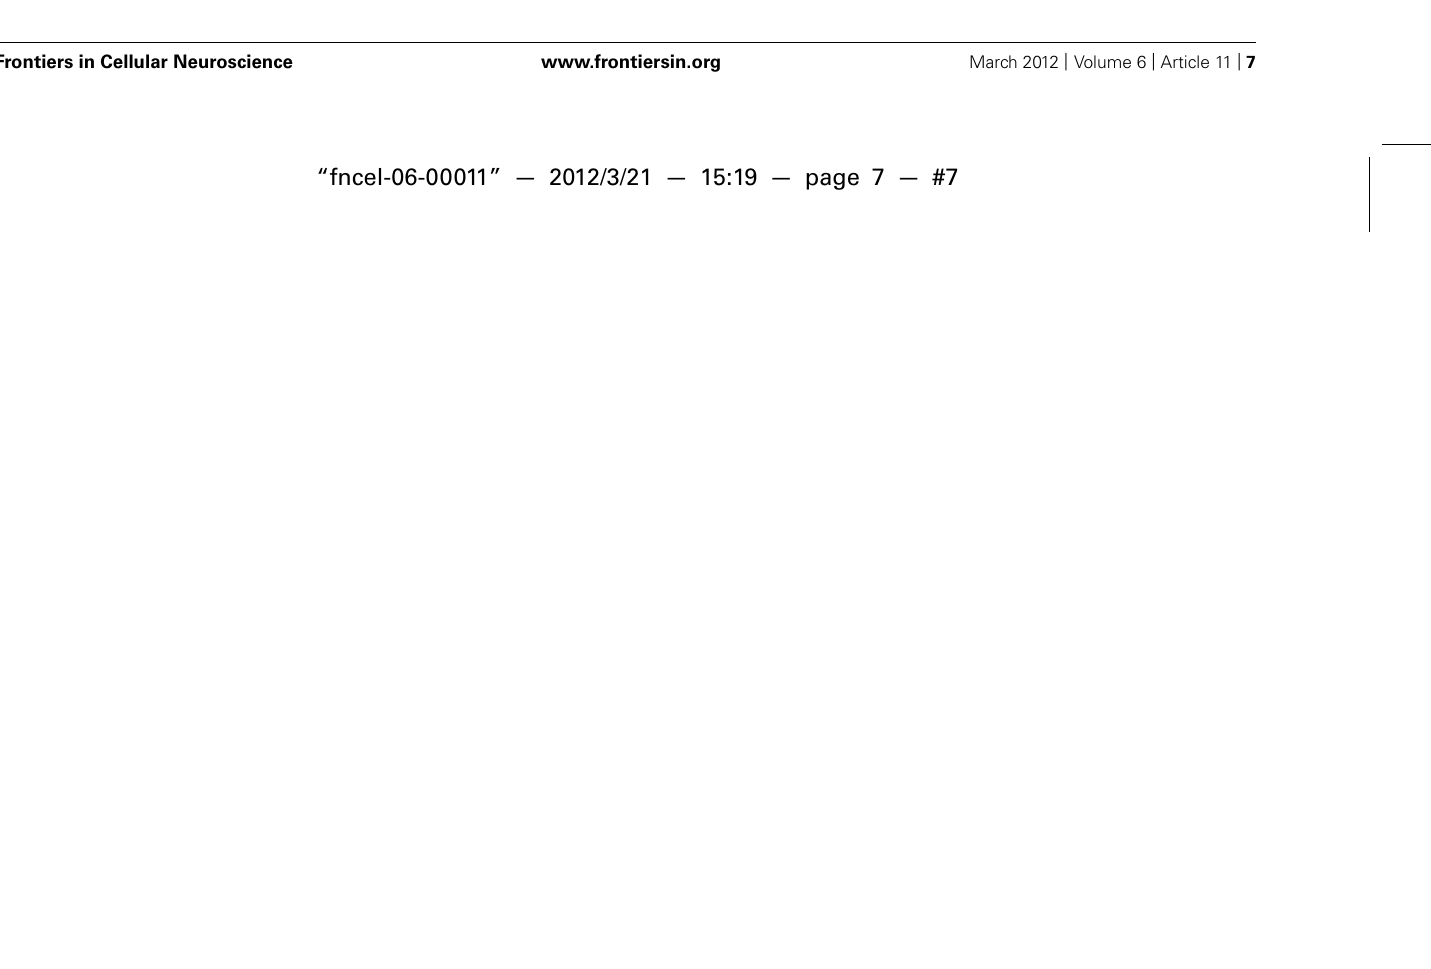
many of the Ki67 + cells also expressed the neural marker Sox2 + (blue; arrowheads show overlap in single color channels). (D) The grafts were rich in differentiated neurons ( > 50%) based on immunohistochemistry for NeuN (red; arrowheads in single color channels highlight the relatively smaller nuclear size of NeuN − cells, which are likely glia). Immunohistochemistry for glial markers showed that the grafts also contained smaller populations of differentiated astrocytes ( E ; GFAP + , blue) and myelinating oligodendrocytes ( F ; RIP + /Olig + ). Scale bars: (A–F) 50 μ